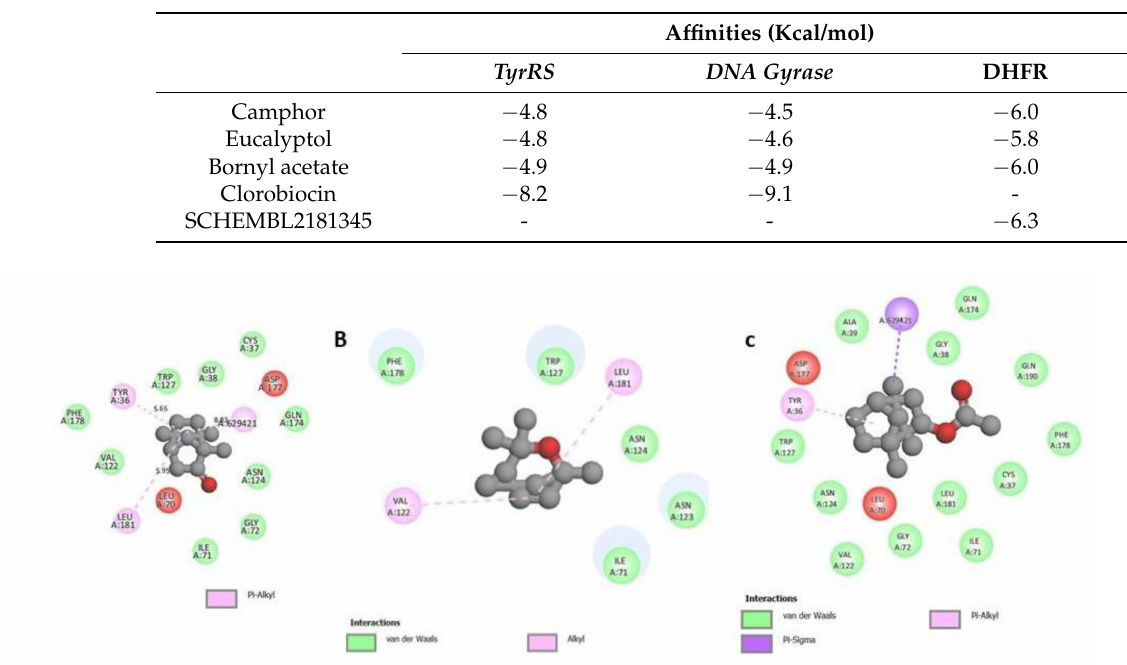
Table 3. Affinity results of the selected receptors and molecules.